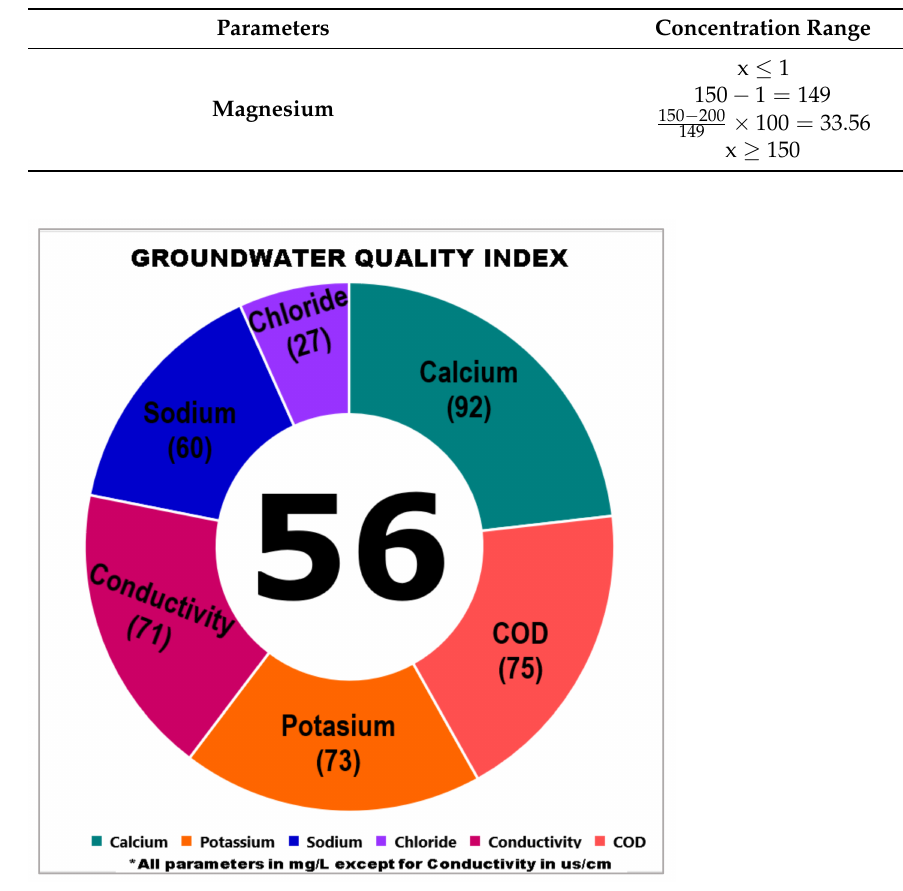
Figure 6. Change in the index value as the Mg concentration increases.